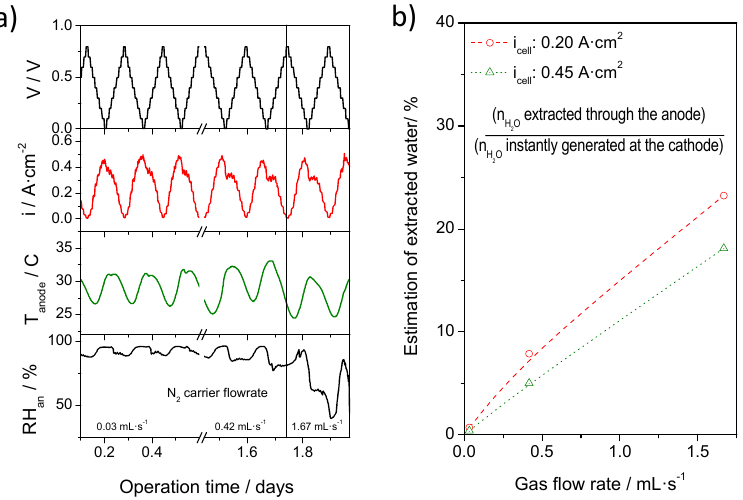
Figure 8. ( a ) Operation parameters of the CIEMAT ABPEMFC assembled to analyze the humidity released from the dead-end anode chamber: cell voltage, cell current density, temperature measured at the sensor in the bag, relative humidity registered by the sensor near the water selectively permeable side of the anode chamber with increasing nitrogen flow rate to sweep the hermetically closed bag (0.03 mL·s − 1 at the beginning of the test, 0.25 mL·s − 1 after 1 day operation, 1.67 mL·s − 1 after cycling during 1.75 days); ( b ) estimation of the percentage of the water instantaneously generated at the cell at 0.2 and at 0.45 A·cm − ² that has been extracted by the external anode chamber surface at different sweep flowrates.